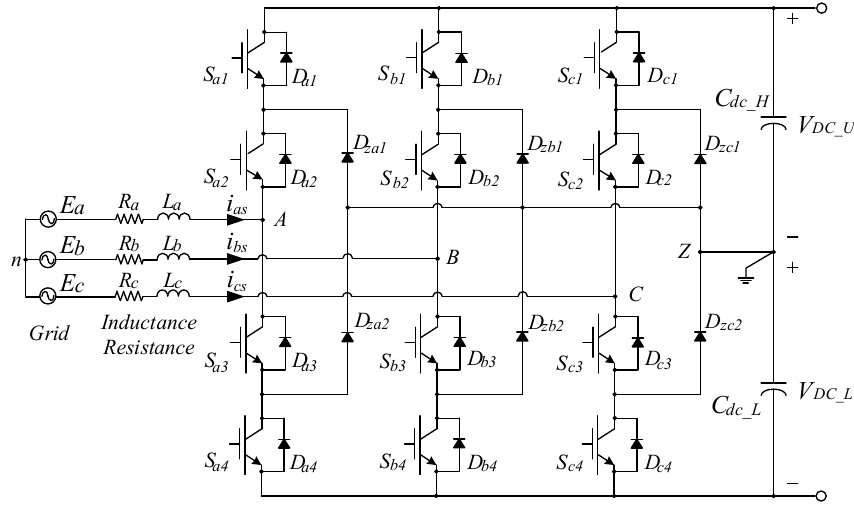
Figure 1. Circuit configuration of the three-phase three-level NPC PWM converter.